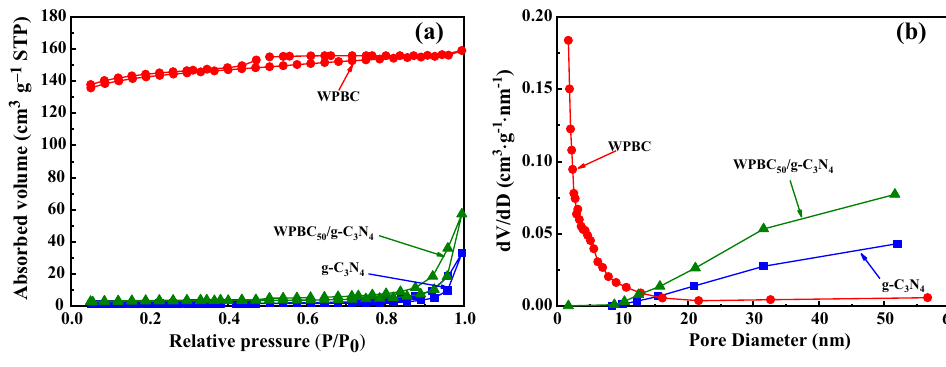
Fig. 3 a Nitrogen adsorption–desorption isotherms and b pore size distributions of WPBC, g-C